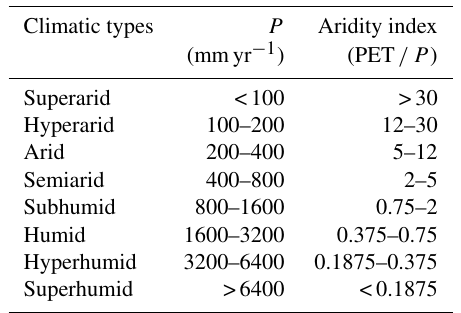
Table 2. The definition of climate types by precipitation and aridity index (Ponce et al.,